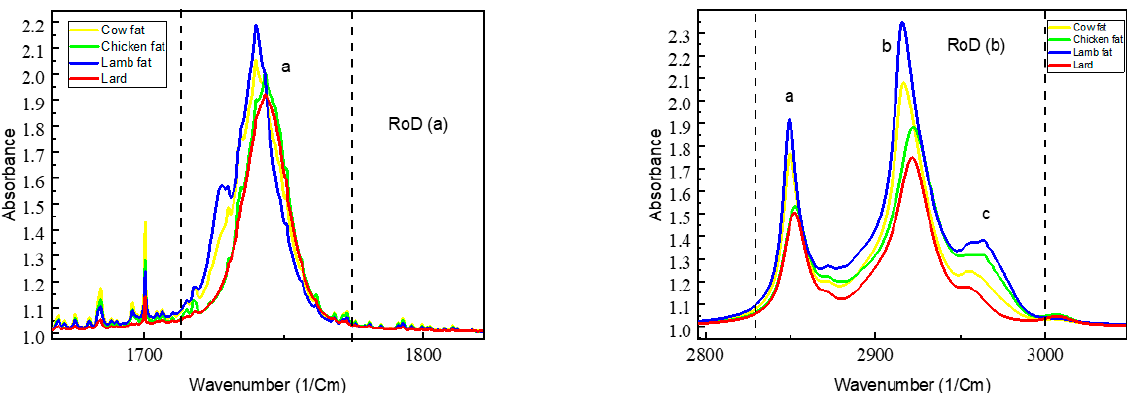
Figure 3. RoD(a) Region of difference peaks zoomed in at wavenumber 1700–1800 cm − 1 showing the absorbance value for pure samples denoted by a; lard has the lowest value among all samples. RoD(b) Zoomed-in peaks at wavenumber 2800–3000 cm − 1 where peaks denoted as a, b, and c represent potential regions with difference in absorbance values for all samples.